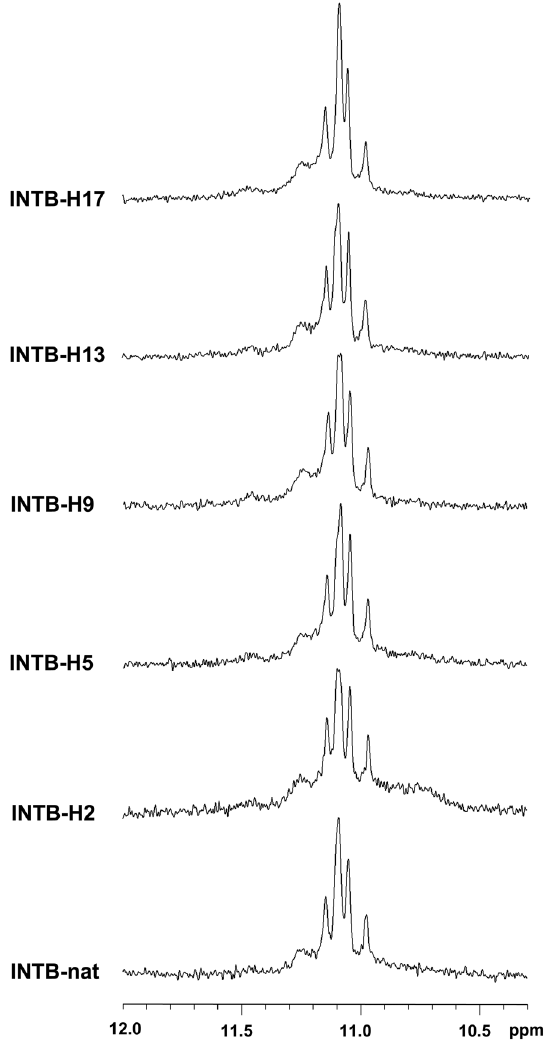
Figure 2. Imino proton regions of the 1 H-NMR spectra (500 MHz) of the ODNs investigated. See main text for